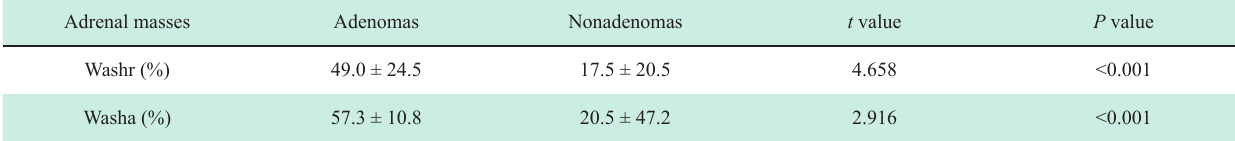
Table 3 Comparison of the washout rate of the 7-min delay timepoint in DCE-CT between adenomas and nonadenomas Adrenal masses